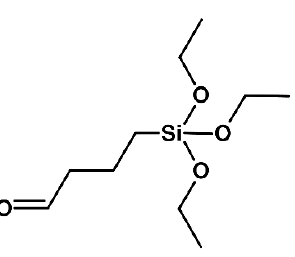
Figure 1. Structural formula of triethoxysilylbutyraldehyde (4-triethoxysilylbutanal).